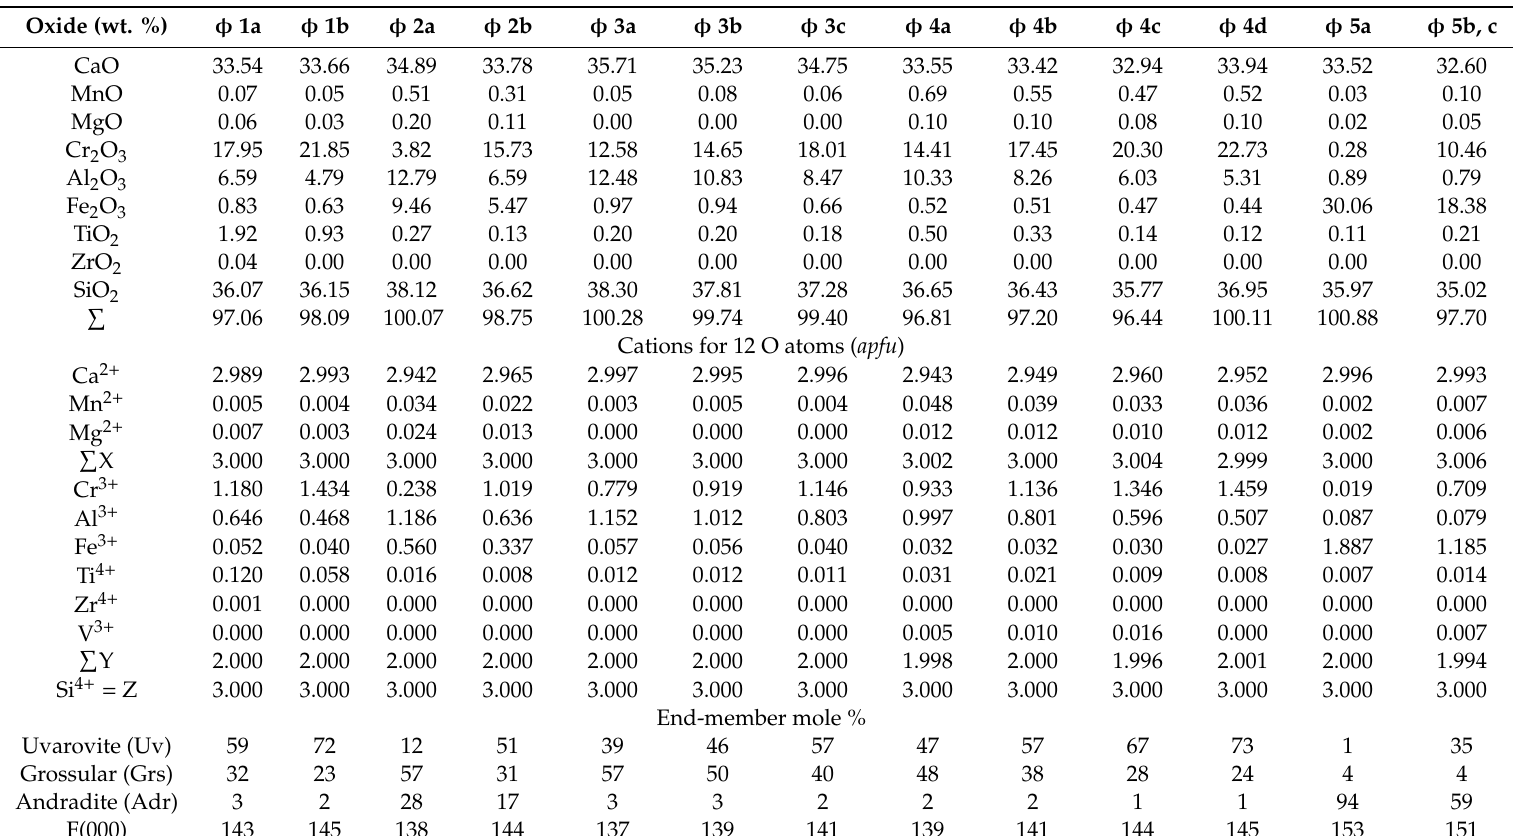
Table 2. Electron-probe microanalysis (EPMA) results for the five uvarovite samples † (including grossular (Grs) and andradite (Adr)) used in this study. Some samples contain more than one garnet phase ( φ